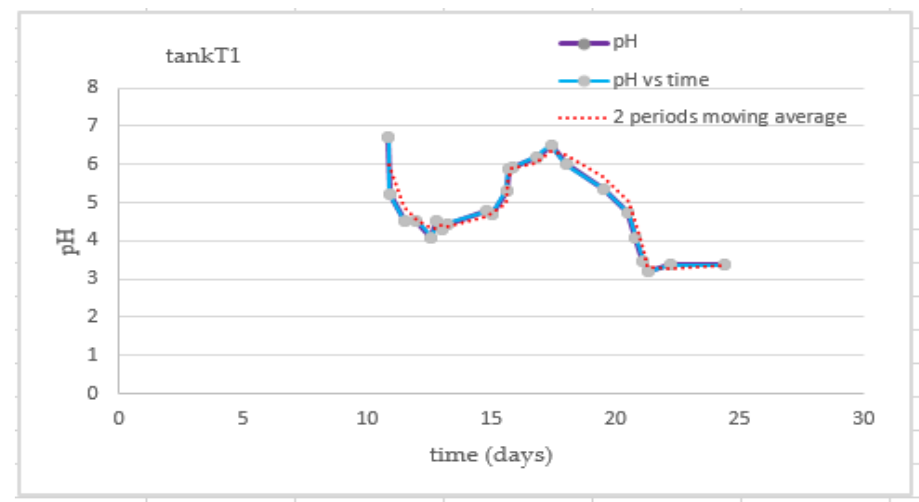
Figure 12. pH data for Tank T0.